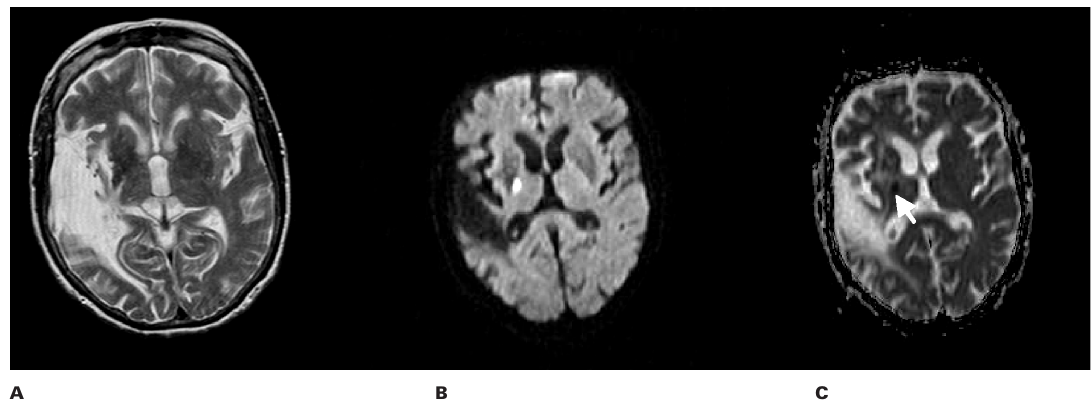
New infarction adjacent to a chronic ischaemic lesion. In a patient with worsening of the pre-existing left hemiparesis, T2-weighted images (A) showed a right temporo-parietal lesion. DW-images (B) visualised a hypointense (“dark”) cortical temporoparietal lesion plus a single hyperintense (“bright”) punctuate lesion in the right internal capsule. This lesion (arrow) appeared hypointense (“dark”) on ADC maps (C) in line with a new infarction. These findings clarified that a recurrent stroke was the cause of the worsened hemiparesis.